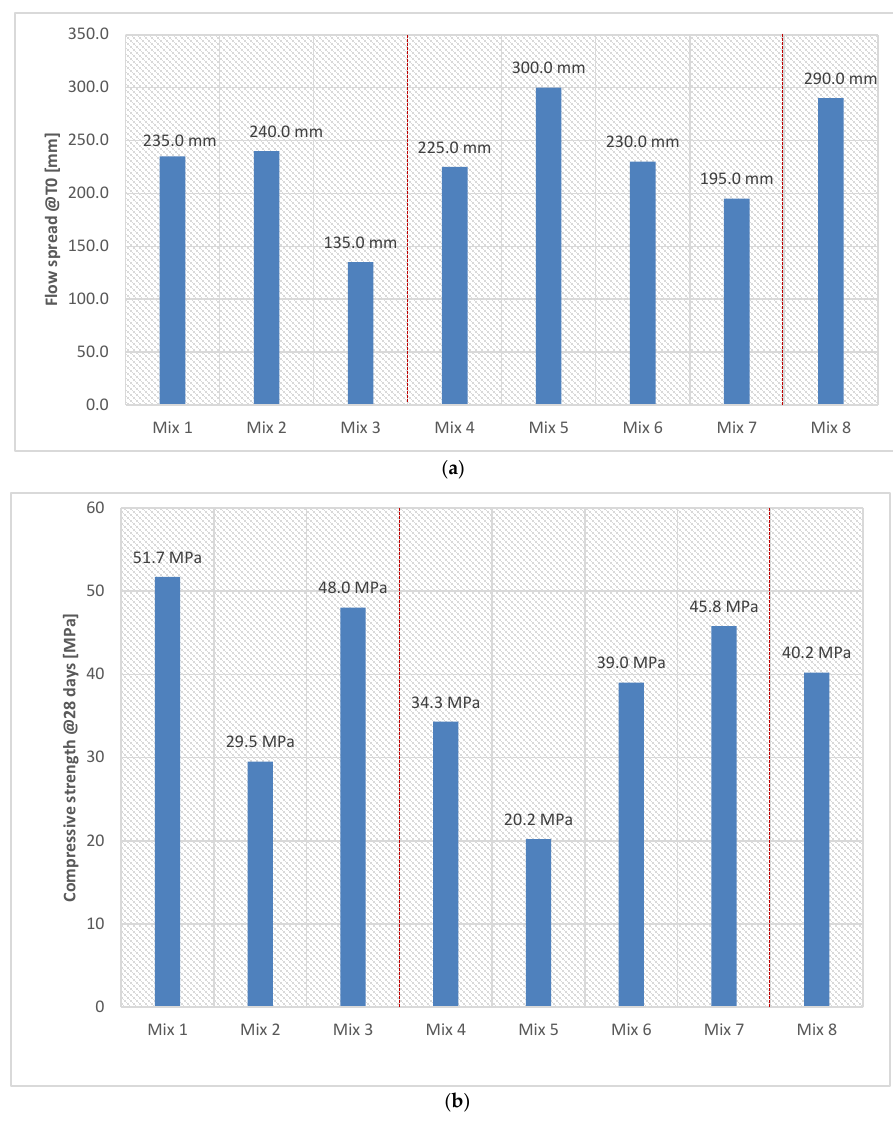
Figure 6. Overview of technical performance of the developed mortars: ( a ) flow spread and ( b ) compressive strength at 28 days’ comparison.